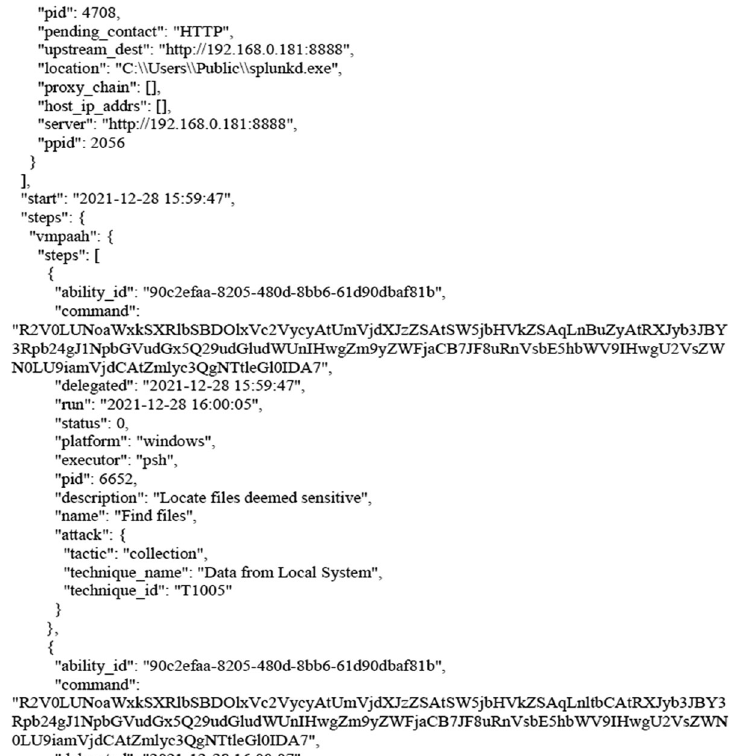
Figure 9. CALDERA